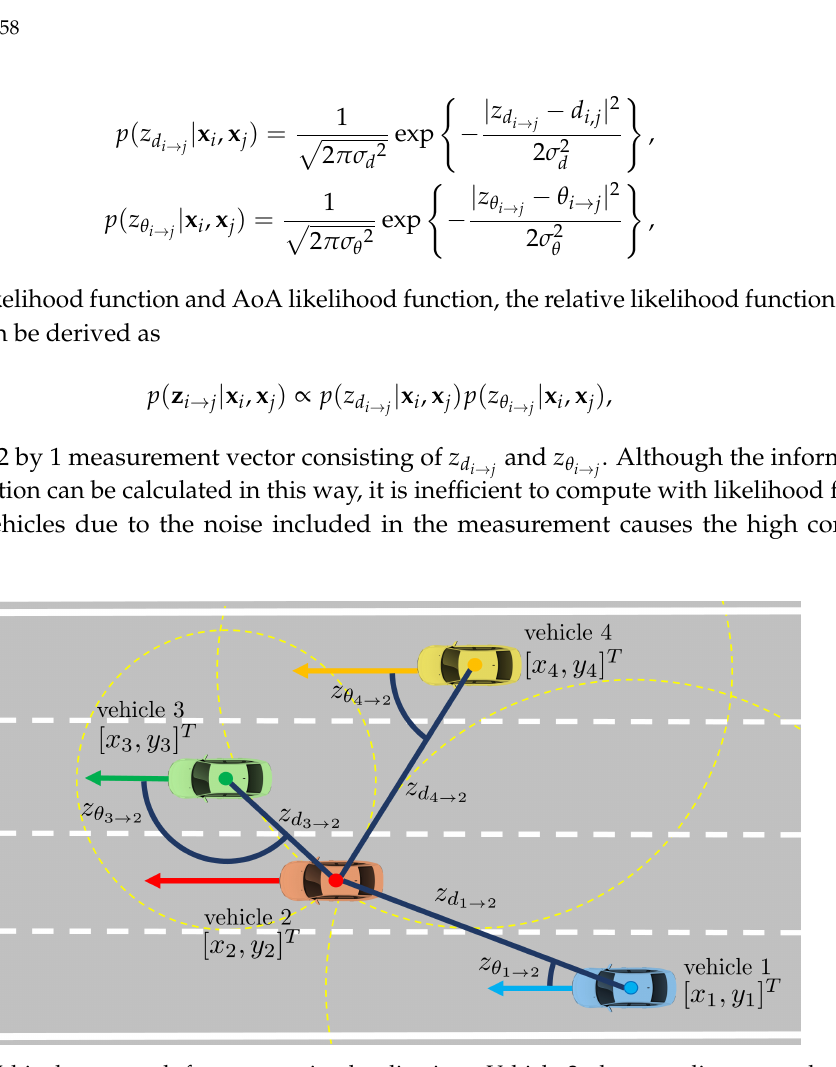
Figure 1. Vehicular network for cooperative localization. Vehicle 2 observes distance and angle measurement from connected